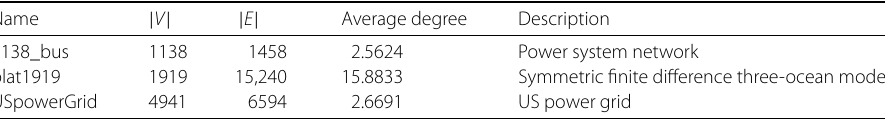
Table 1 Datasets from the literature * Name